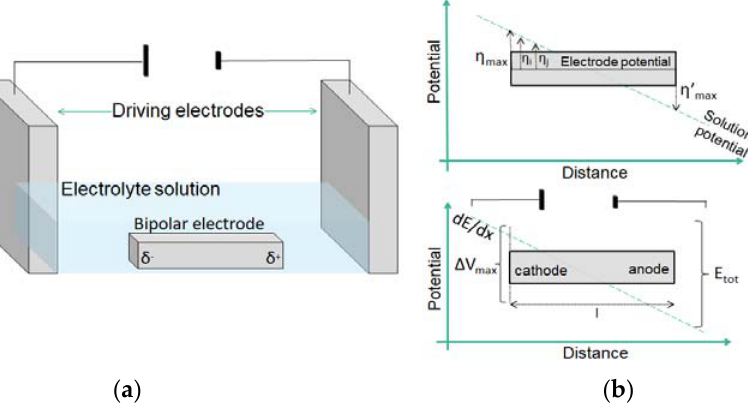
Figure 2. ( a ) Schematic illustration of a bipolar electrode setup. ( b ) Schematic of the magnitude of the interfacial potential difference between the BPE and the solution. The magnitude of the overpotentials varies along the length of the electrode, assuming the highest values at its extremities.